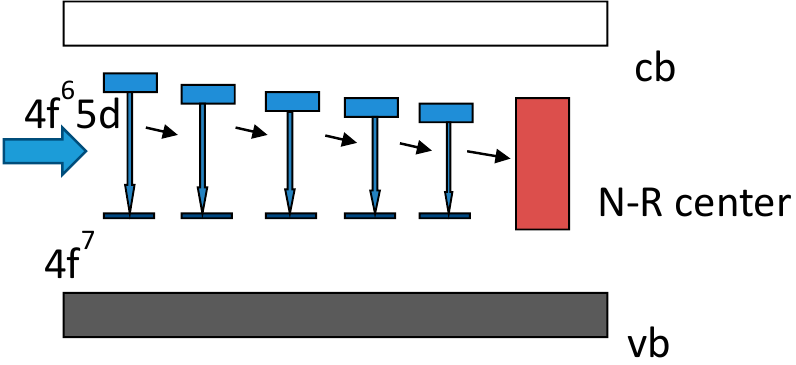
Figure 13. Diagram representing the energy transfer between the Eu 2+ ions (represented by the ground 4f 7 and excited states 4f 6 5d) in Ca,Eu- α -sialon and between the Eu 2+ ions and nonradiative centers. High pressure PL measurements confirmed the multisite Eu 2+ in the samples. We observed a pressure induced red shift of the Eu 2+ PL band with a rate approximately equal to 4.35 cm − 1 /kbar. This is rather a small rate in comparison to other materials doped with Eu 2+ , which is usually two times larger [43].